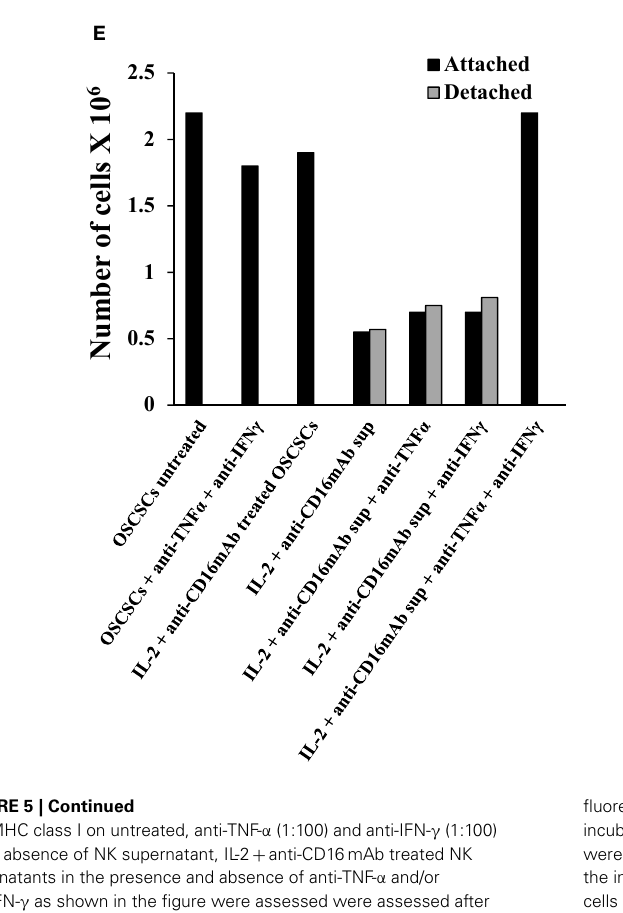
fluorescence intensities in each histogram (D) . At the end of the incubation of OSCSCs with NK cell supernatants, OSCSCs which were remained attached to the plate and those which detached during the incubation period were collected separately, and the number of cells (E) and their viability (F) were assessed using microscopy, and propidium iodide staining followed by flow cytometric analysis, respectively. One of minimum three representative experiments is shown in each of (A–F) .